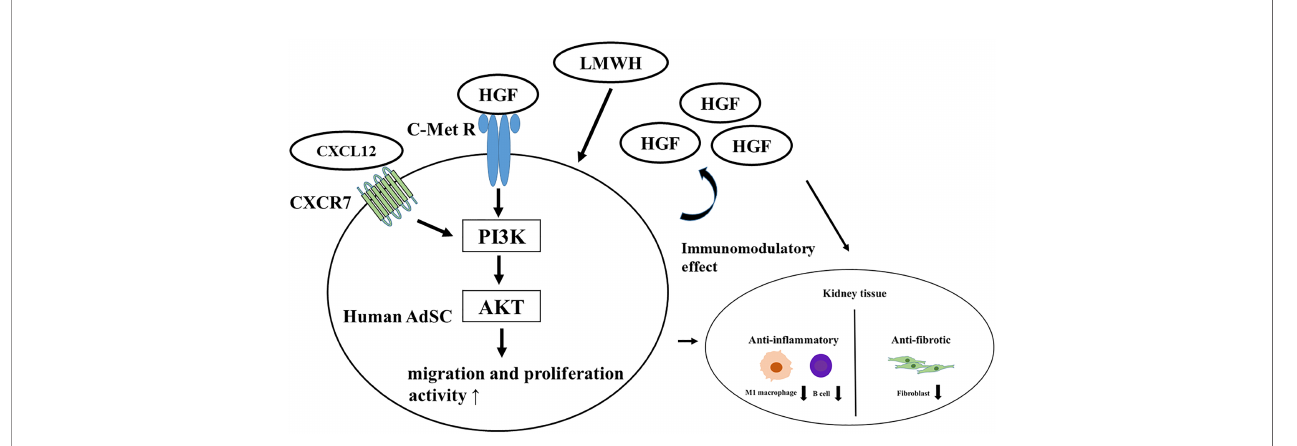
FIGURE 6 | Therapeutic mechanism of hep-hASCs on lupus nephritis. LMWH promotes the production of HGF protein from hASC, and HGF activates PI3K/Akt pathway through c-MET receptor. Also, LMWH activates the CXCL12/CXCR7 pathway in hep-hASCs, leading to the activation of migration, proliferation, and homing capacity to kidney. In addition to activated cell function of hep-hASCs, increased amount of HGF protein from hep-hASCs has an anti-in fl ammatory and anti- fi brotic effect, leading to the improvement of LN. ASCs, adipose-derived mesenchymal stem cells; HGF, hepatic growth factor; PI3K, phosphatidylinositol-3-kinase; CXCR, C-X-C motif chemokine